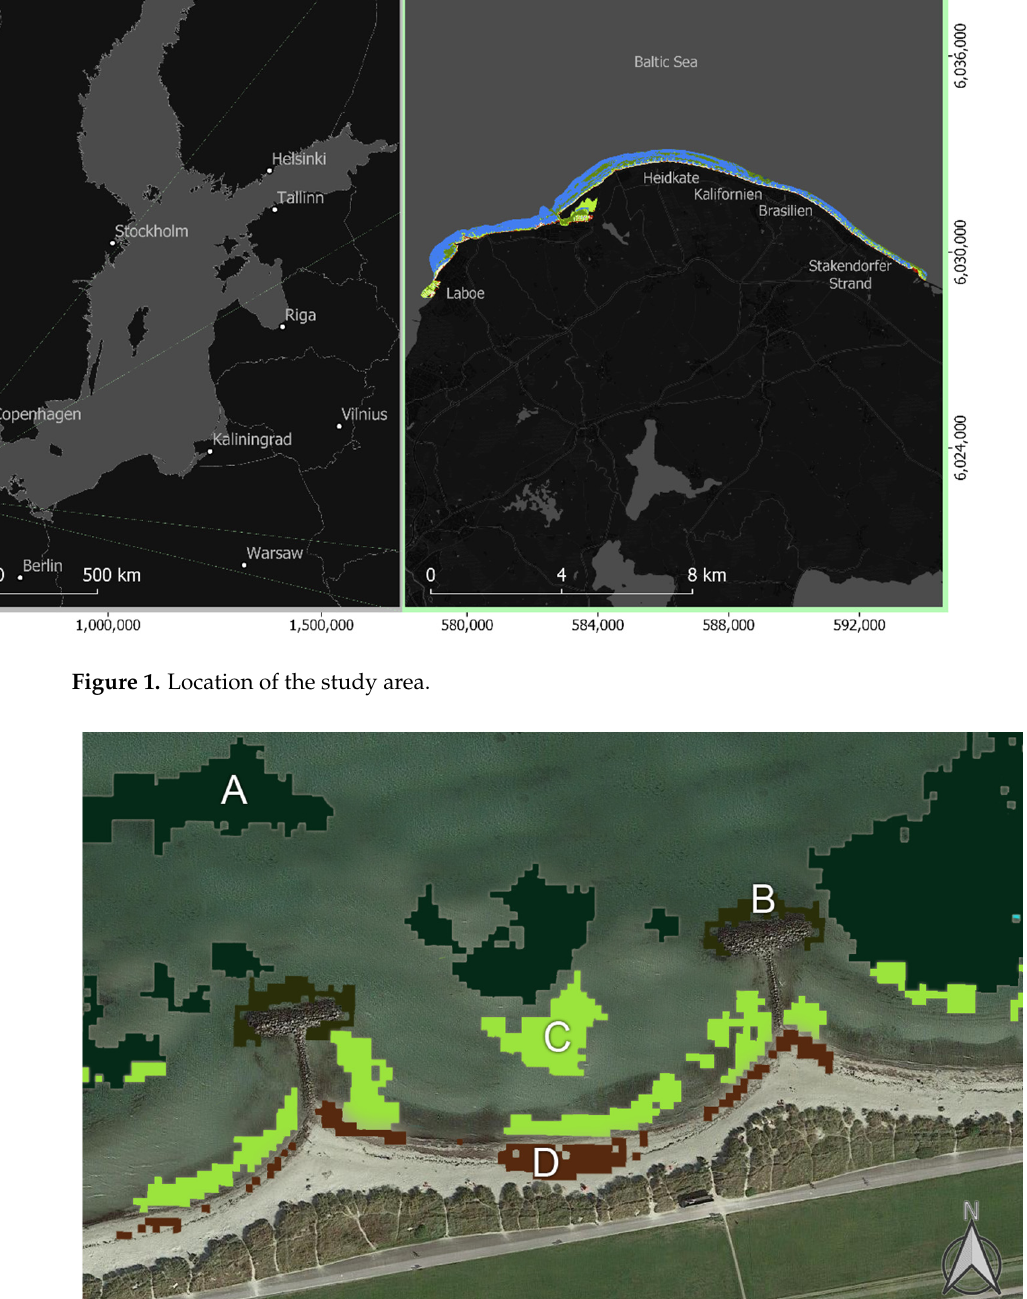
Figure 2. Schematic illustration of the typical zonation of the four dominant aquatic vegetation groups modified from PS data. (A—dark green) submerged seagrass, (B—moss green) fixed brown algae, (C—light green) drifting mix of seagrass and macroalgae and (D—brown) beach cast mixed of seagrass and macroalgae. Background map data: modified Google